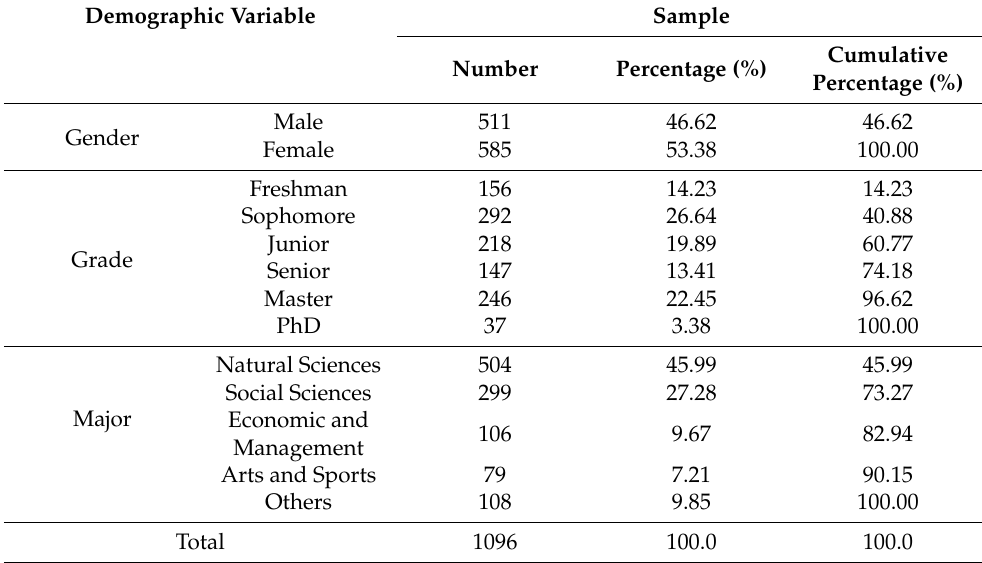
Table 1. Demographic information of the